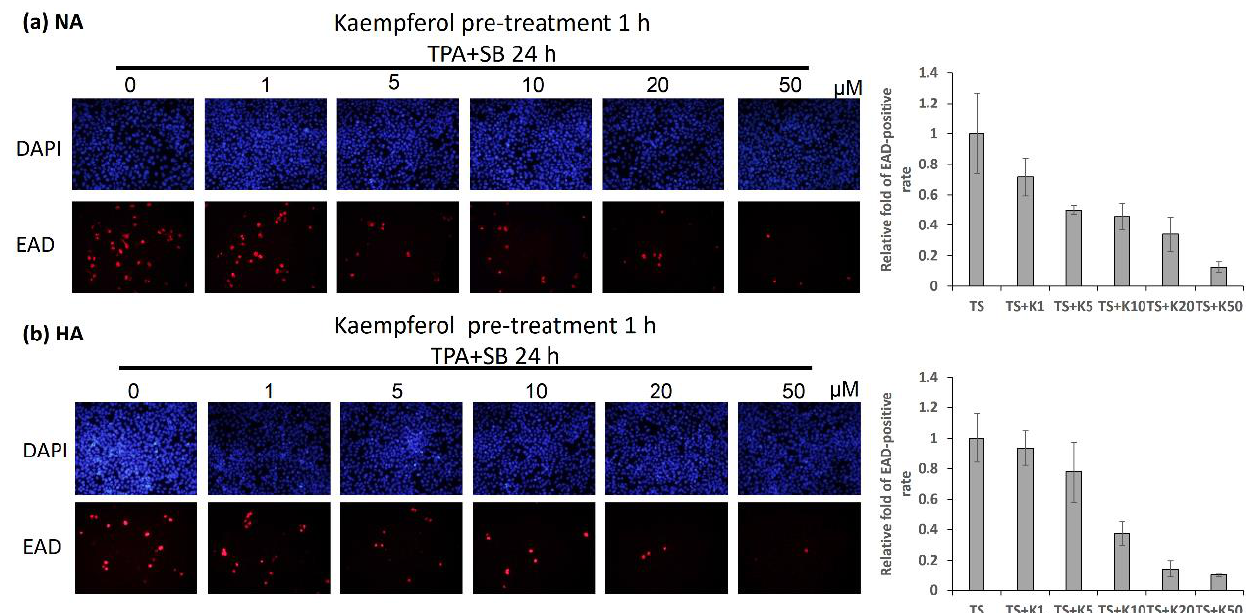
Figure 3. Kaempferol treatment decreased the number of EAD-positive cells. ( a ) NA and ( b ) HA cell lines were prepared for immunofluorescence analysis. To determine the inhibition of EBV reactivation by kaempferol, the cells were pre-treated for 1 h. TPA and SB were added to induce EBV reactivation. After 24 h of treatment, the cells were treated with EAD antibody and analyzed by fluorescence microscopy. The statistical results are shown as relative folds in the left panels of the figures. The values of each sample were derived from three independent trials. TS: TPA + SB; K1, K5, K10, K20 and K50: 1, 5, 10, 20 and 50 µ M